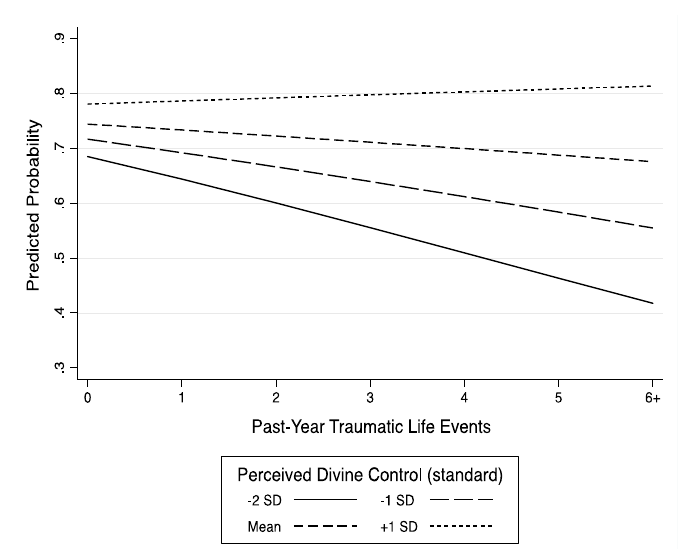
Figure 2. Traumatic life events × divine control on positive reappraisal coping.